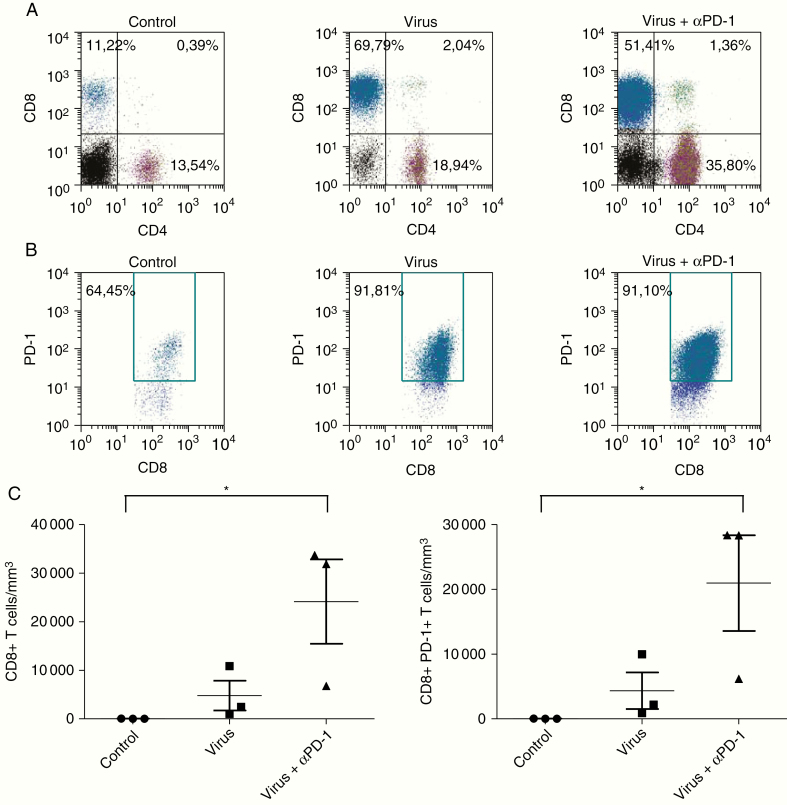
Low-dose Delta24-RGD combined with PD-1 blockade increases PD-1+ TILs. Mice bearing GL261 tumors (n = 3/group) and treated as described in Figure 4A were euthanized 14 days post-therapy and brains were processed into single cells for flow cytometry. (A) Flow cytometric analysis showed an increased percentage of CD8+ T cells (cells gated on CD3+ T cells) after Delta24-RGD therapy only (middle panel) and in combination with anti-PD-1 therapy (right panel). (B) Intratumoral CD8+ T cells highly express PD-1 (cells gated on CD3+CD8+ T cells). (C) Combination therapy significantly increased the absolute numbers of CD8+ T cells and PD-1+ CD8+ T cells per mm3 tumor. P values were calculated by ANOVA with post-hoc Tukey test. *P < .05.